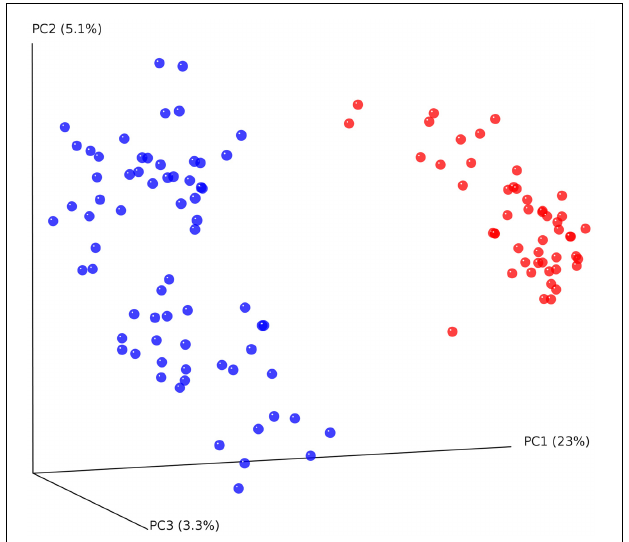
FIGURE 3 | Principal coordinate analysis (PCoA) plot of cheetahs (blue) and black-backed jackals (red) based on unweighted UniFrac metric. The two host species differ significantly in their bacterial communities [PERMANOVA: R 2 = 0 . 74, F (1 , 116) = 337 , 02, p < 0 . 001].